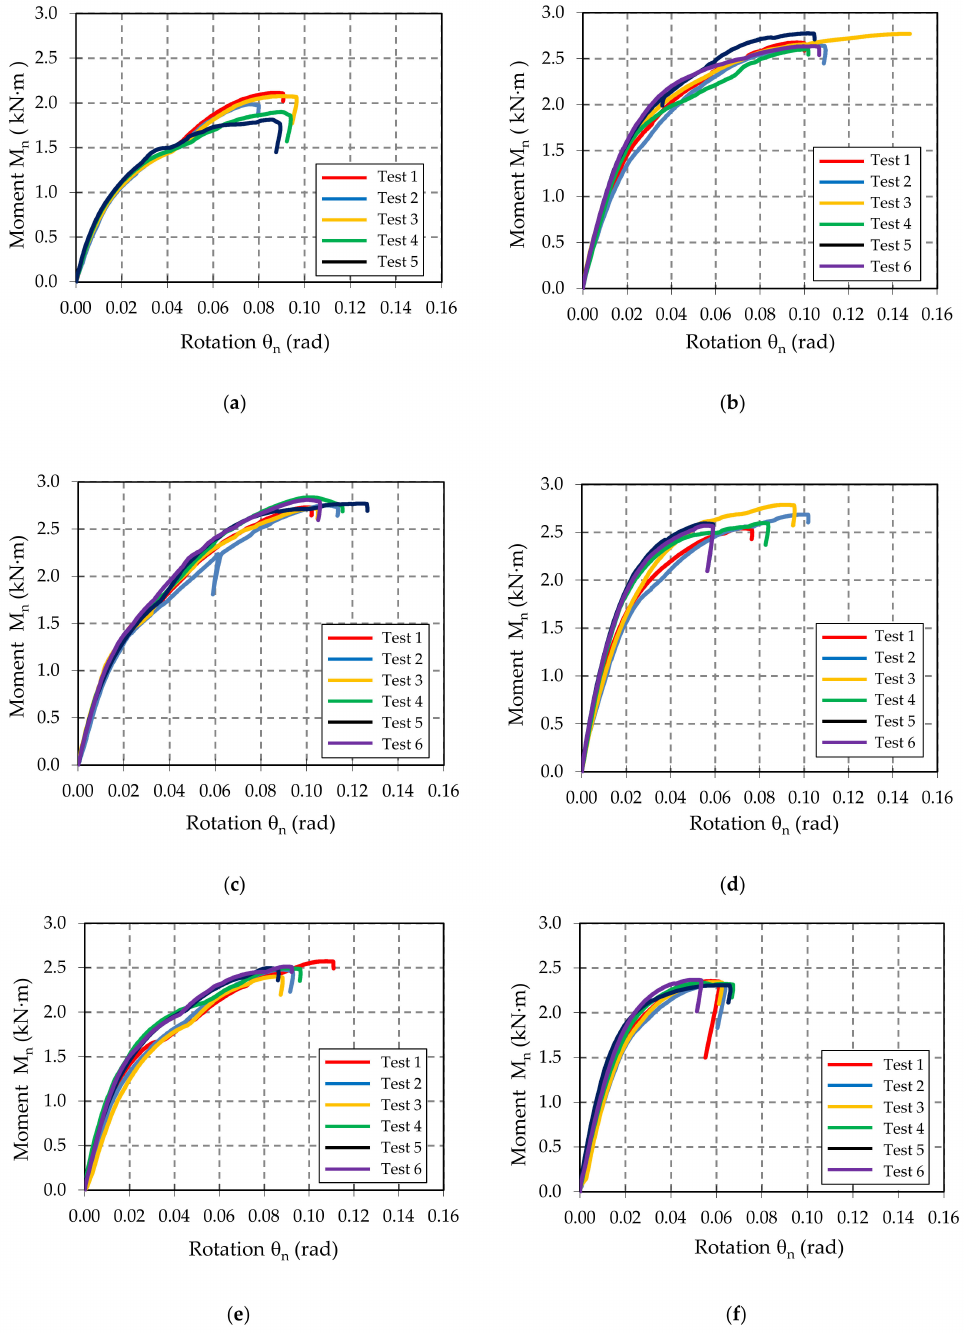
Figure A1. Moment-rotation (M n – θ n ) curves recorded for the beam-connector-upright assemblies: ( a ) A-I-4L, ( b ) A-I-5L, ( c ) A-II-4L, ( d )A-II-5L, ( e ) A-III-4L, and ( f )